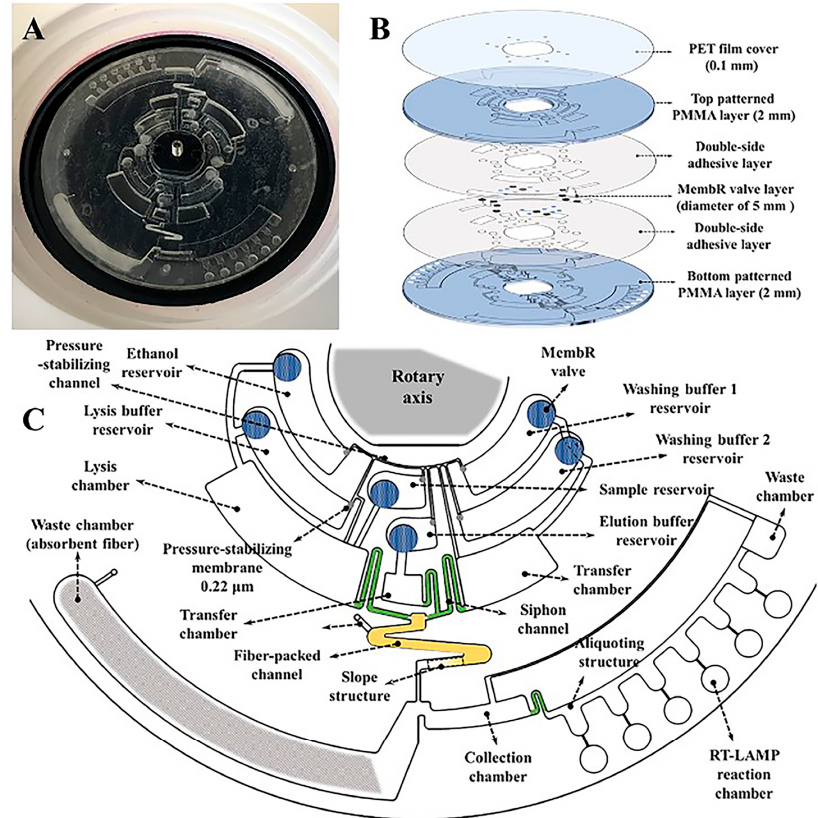
Figure 7. ( A ) Photograph of the assembled disc. ( B ) Assembly of the disc consisting of a PET film cover, a top patterned polymethyl methacrylate (PMMA) layer, a MembR valve layer, a bottom patterned PMMA layer, and two double-side adhesive layers. ( C ) Design of the diagnostic platform including six reservoirs with different solutions, a fibre-packed channel, an aliquoting structure, and six chambers for RNA extraction and RT-LAMP reaction; six different MembR valves, four transfer chambers and waste chambers. Reproduced with permission from [84].